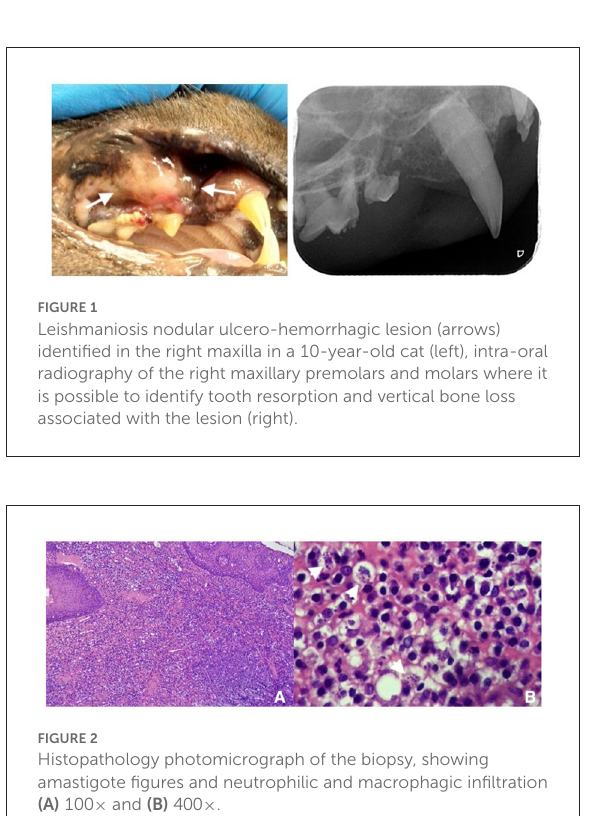
painful with spontaneous bleeding. Bilateral mandibular lymph node enlargement was also observed. No other anomalies were